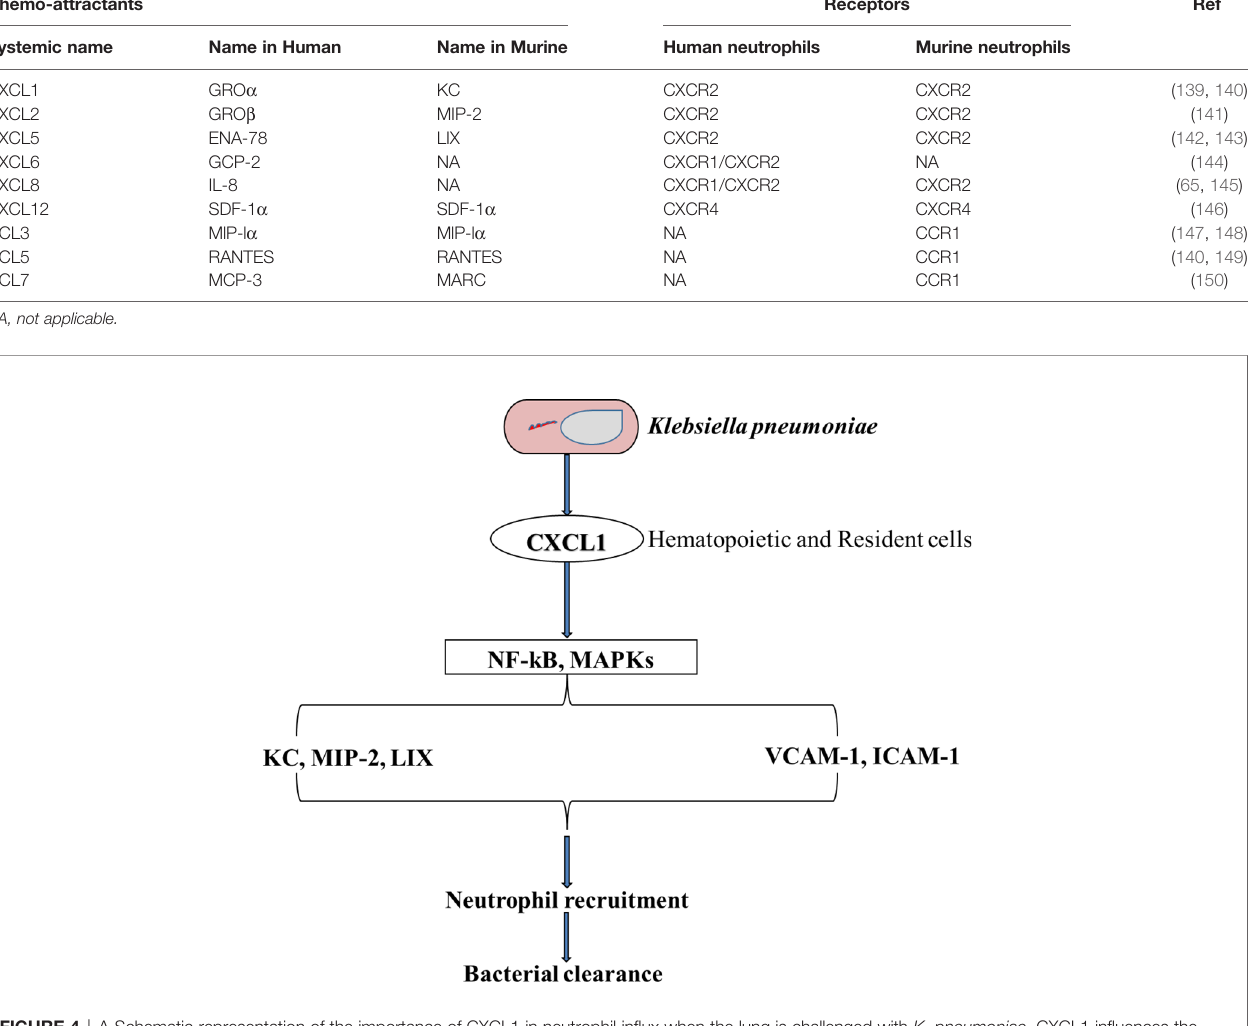
FIGURE 4 | A Schematic representation of the importance of CXCL1 in neutrophil in fl ux when the lung is challenged with K. pneumoniae . CXCL1 in fl uences the activation of both NF-kB and MAPK which leads to an increase in MIP-2 and LIX chemokines, and other adhesion molecules such as VCAM-1 and ICAM-1. This cascade of events leads to an in fl ux of the lungs with neutrophils followed by the clearance of the bacteria (154).